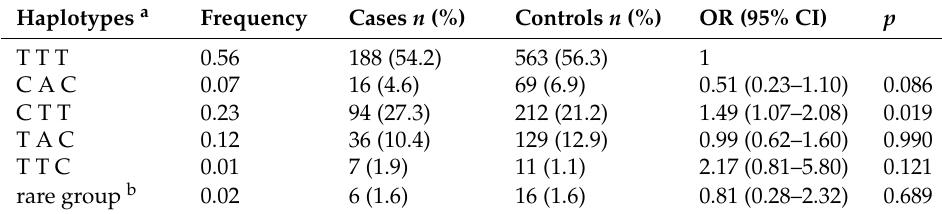
Table 5. Frequencies of haplotypes among cases and controls and association with risk of CAD. Haplotypes